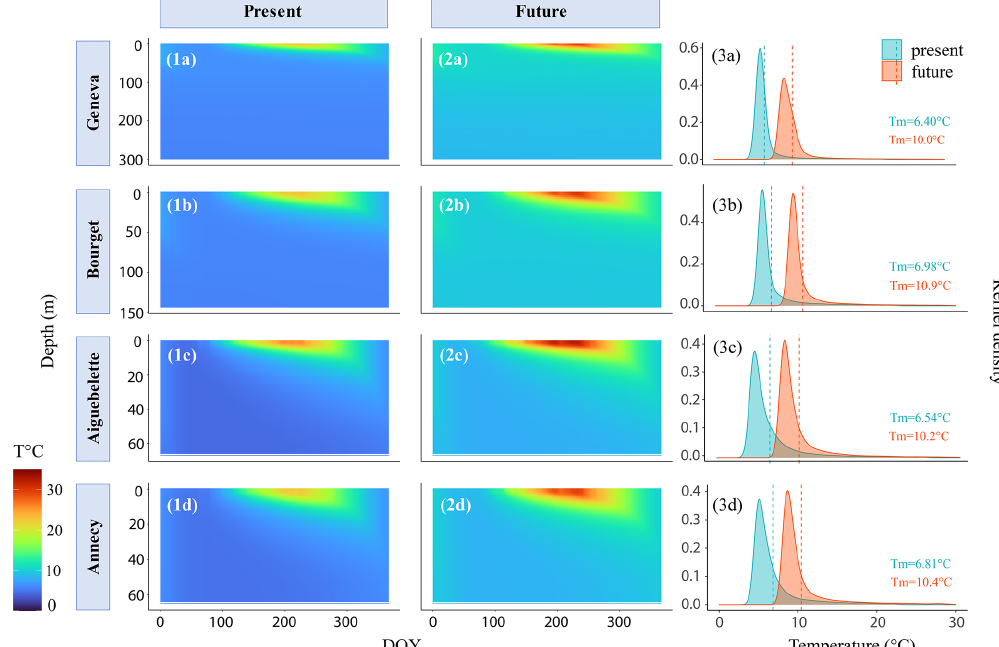
Figure 6. MyLake water temperature simulations from intermediate climate scenario (SSP370). Daily averaged water temperature over the periods 2000–2010 (1) and 2090–2100 (2) in Lake Geneva (a) , Bourget (b) , Aiguebelette (c) , and Annecy (d) . Estimated frequency of daily average temperature data (3) over the present (2000–2010) and the future (2090–2100) using kernel density. The dashed lines represent average annual temperatures over the entire